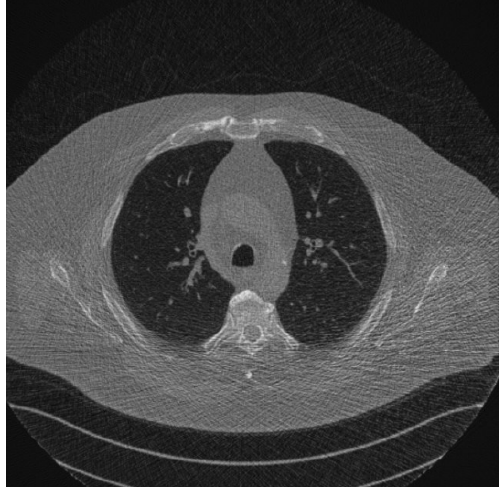
Figure 3. Chest reconstruction from the “Low Dose CT Grand Challenge”